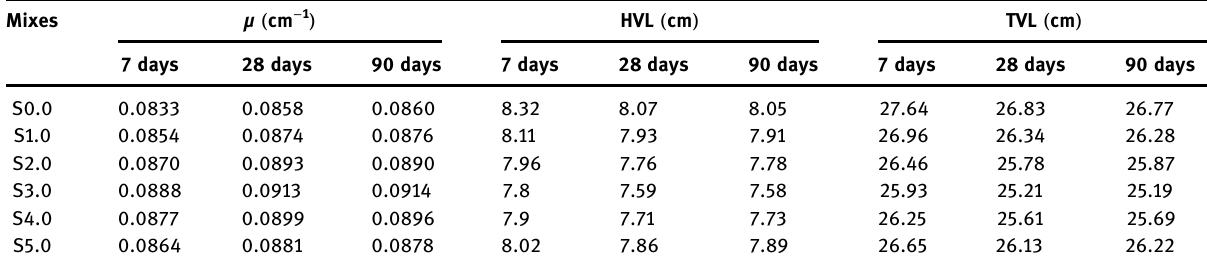
Table 3: Relationship between HVL, TVL, and µ of SSHWC mixes subjected to X - Ray Mixes µ ( cm − 1 ) HVL ( cm )